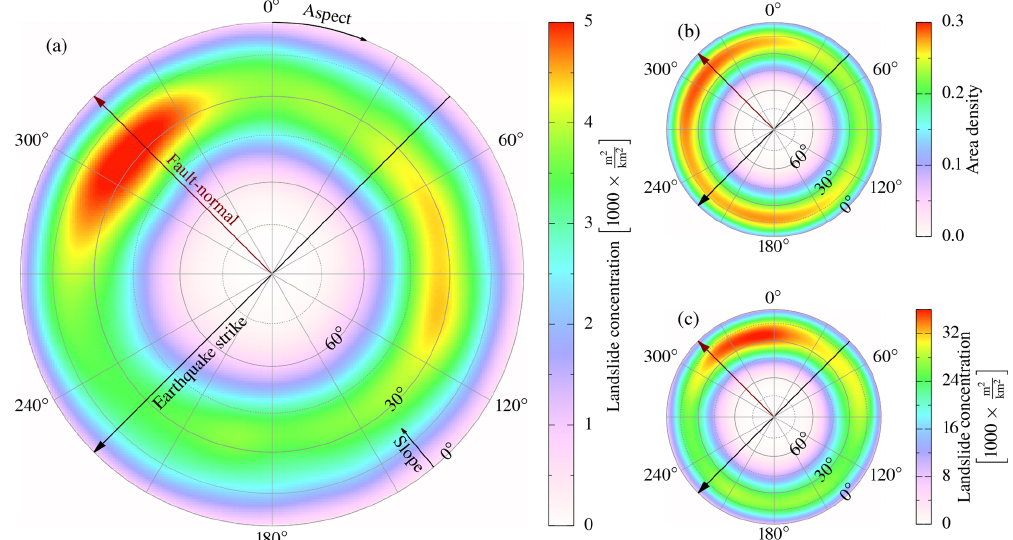
Figure 12. (a) Aspect and hillslope inclination distribution within areas of the earthquake-triggered landslides. This distribution is normalized by the distribution of the aspect of all hillslopes in the landslide-affected area. The black line denotes the strike of the Kumamoto earthquake (225 ◦ ). (b) Distribution of aspect and hillslope inclination in the landslide-affected area; (c) same as in (a) but for unspecified